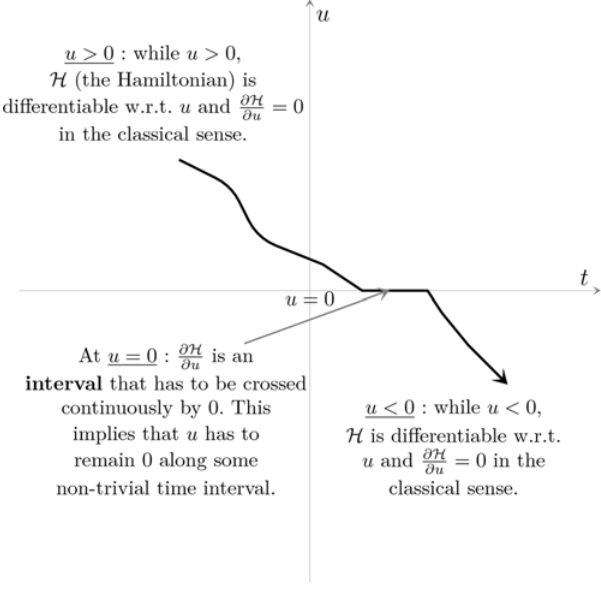
Figure 9. Intuitive illustration of the Inactivation Principle